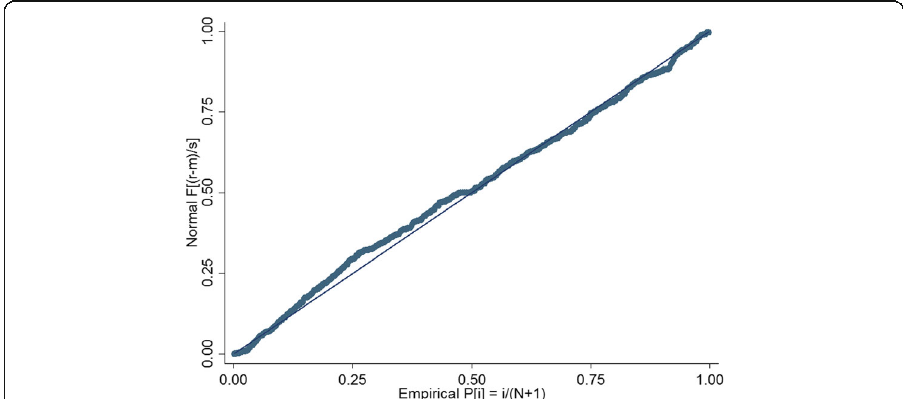
Fig. 5 Standardized normal probability plot comparing the distribution of residuals to a normal